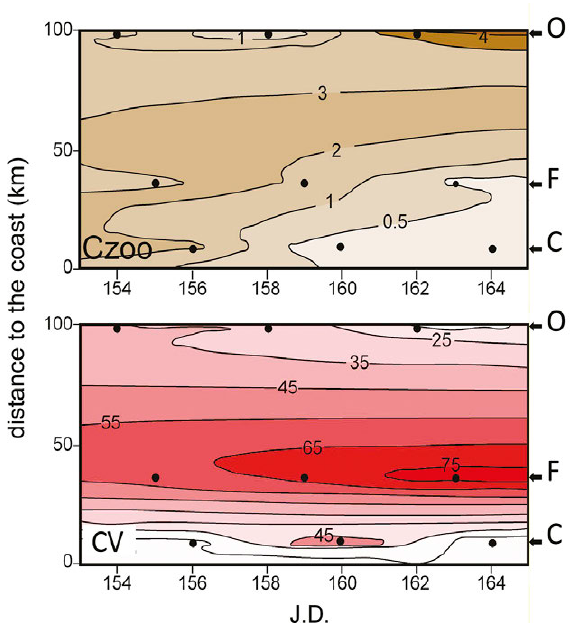
Fig. 5. – Depth-integrated average values of mixed day and night samples of mesozooplankton biomass (C ) and its variability ZOO, (CV) along the studied transect during the period analysed. Hori- zontal axis, sampling day (JD); vertical axis, distance from the coast (km). The integrated depth was 60 m for Station C and 100 m for Stations F and O.